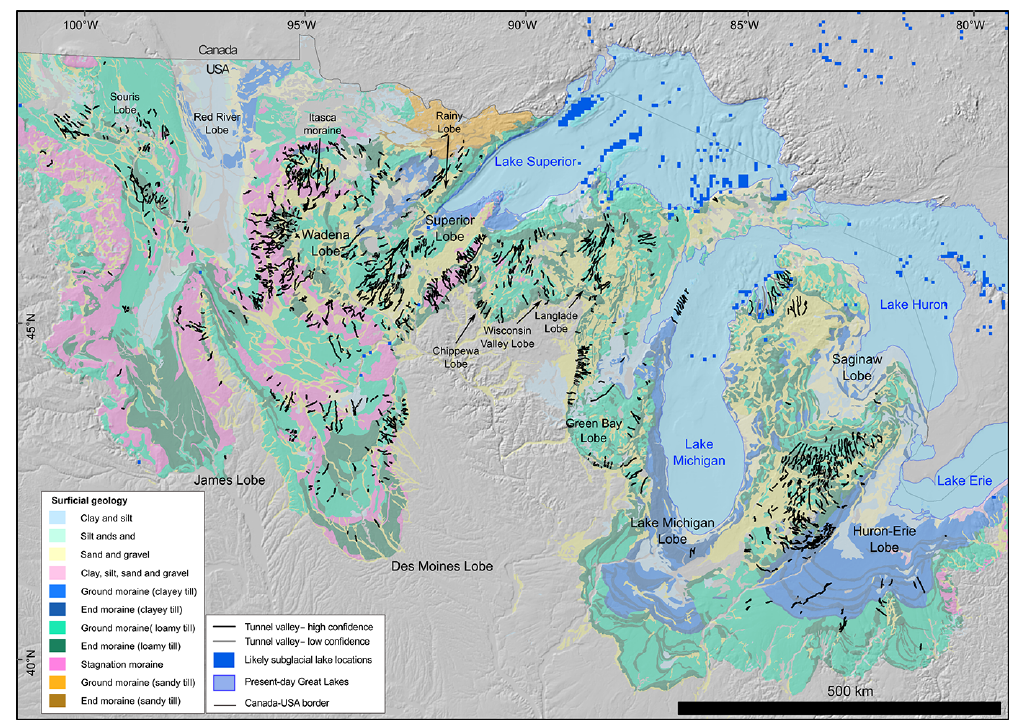
Figure 4. Distribution of mapped tunnel valleys and moraines along the southern sector of the Laurentide Ice Sheet. Likely subglacial lake locations are predictions from Livingstone et al. (2013). The Last Glacial Maximum extent is from Dyke et al. (2004) and surficial deposits are from Fullerton et al.